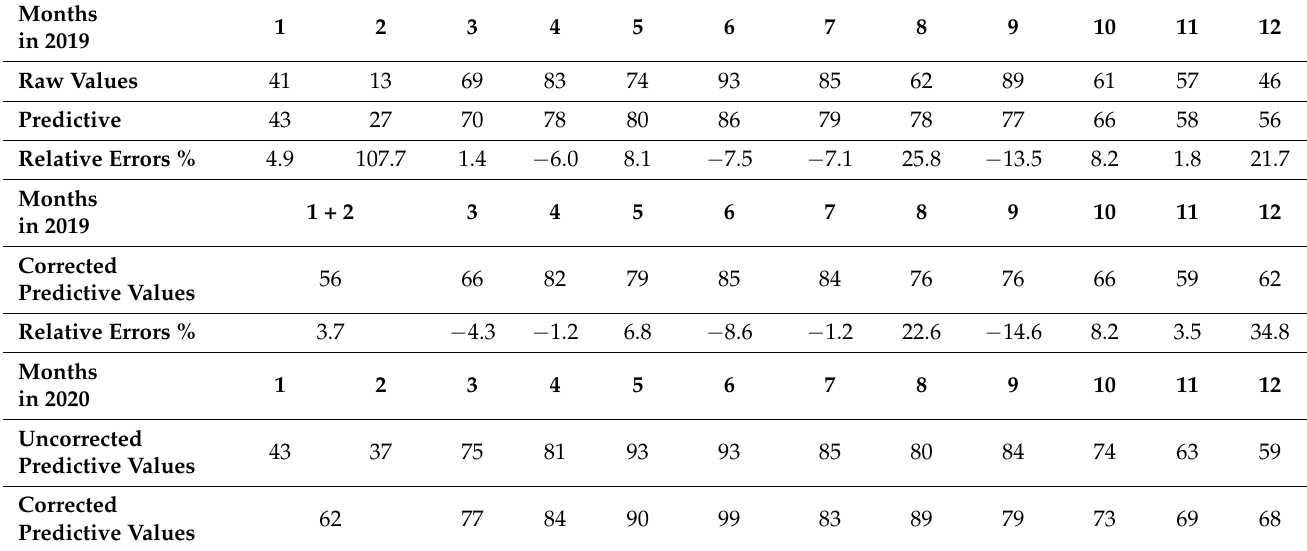
Table 3. Monthly forecast results for accidents.